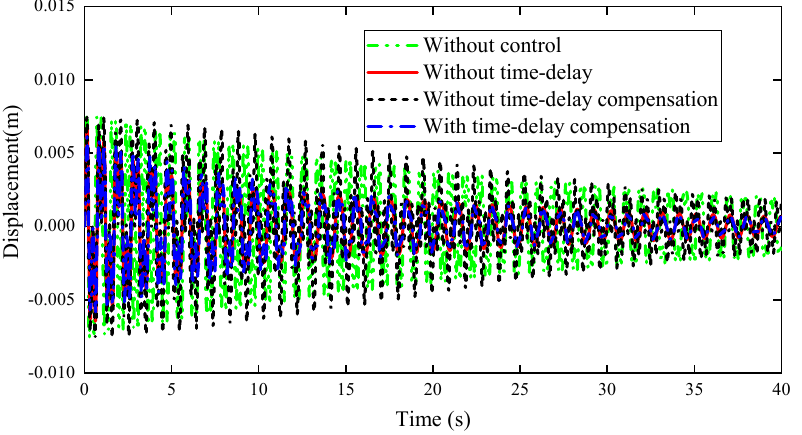
Figure 6. The time history of displacement at mid-span under free vibration (0.11 s time-delay).